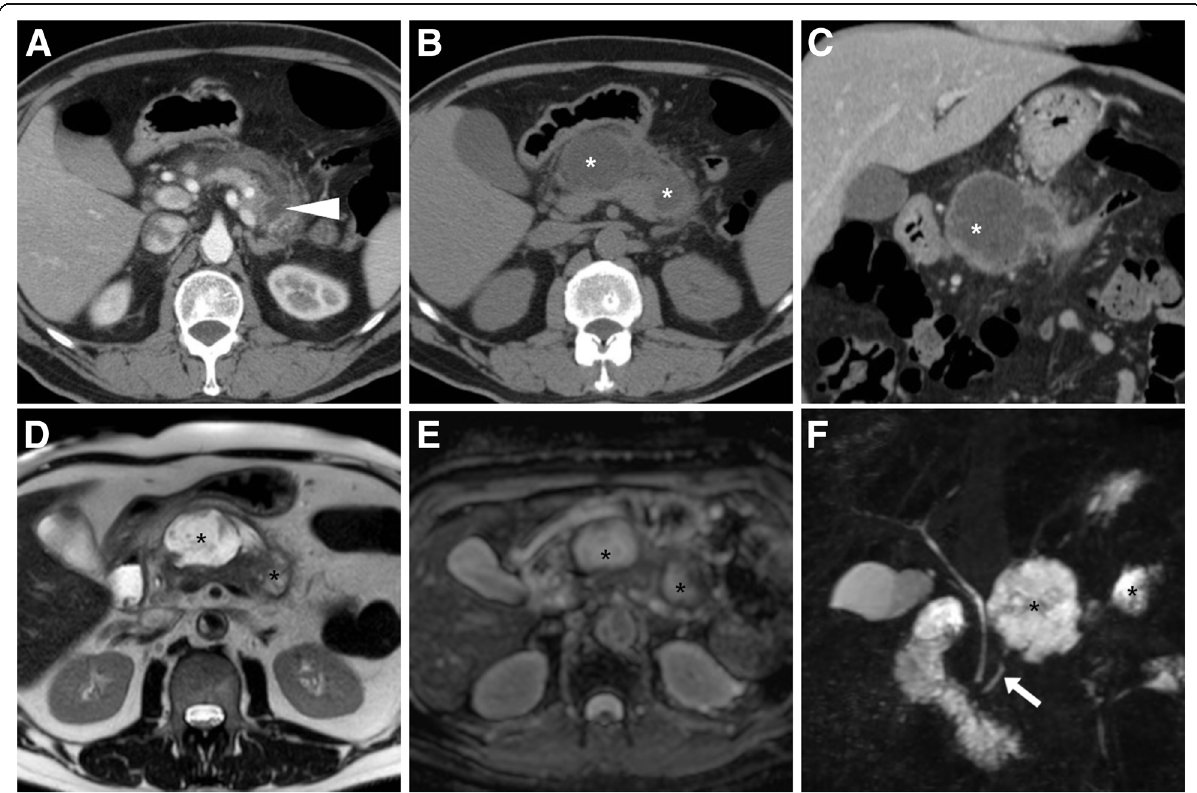
Fig. 1 In a 55-year-old male with clinical and laboratory diagnosis of acute pancreatitis (AP), initial contrast-enhanced multidetector CT (MDCT, a ) showed mild peripancreatic oedema and a limited region of nonenhancing parenchyma (arrowhead) at the pancreatic tail. Follow-up unenhanced ( b ) and post-contrast ( c ) CT showed development of a bilobated hypoattenuating collection (*) in the lesser sac. A month later, MRI confirmed diagnosis of non-infected walled-off pancreatic necrosis (WOPN) by showing persistent collection (*) with internal low-signal debris on T2-weighted images ( d ), without restricted diffusion on apparent diffusion coefficient (ADC) map ( e ). Note superimposition of collection (*) on the main pancreatic duct (MPD, arrow) on MR-cholangiopancreatography (MRCP) image ( f